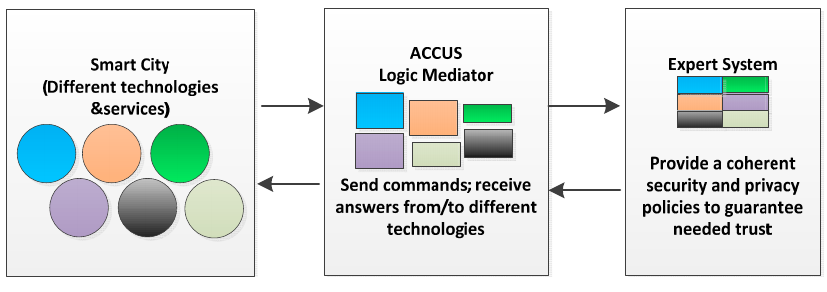
Figure 10. Mediation chain.